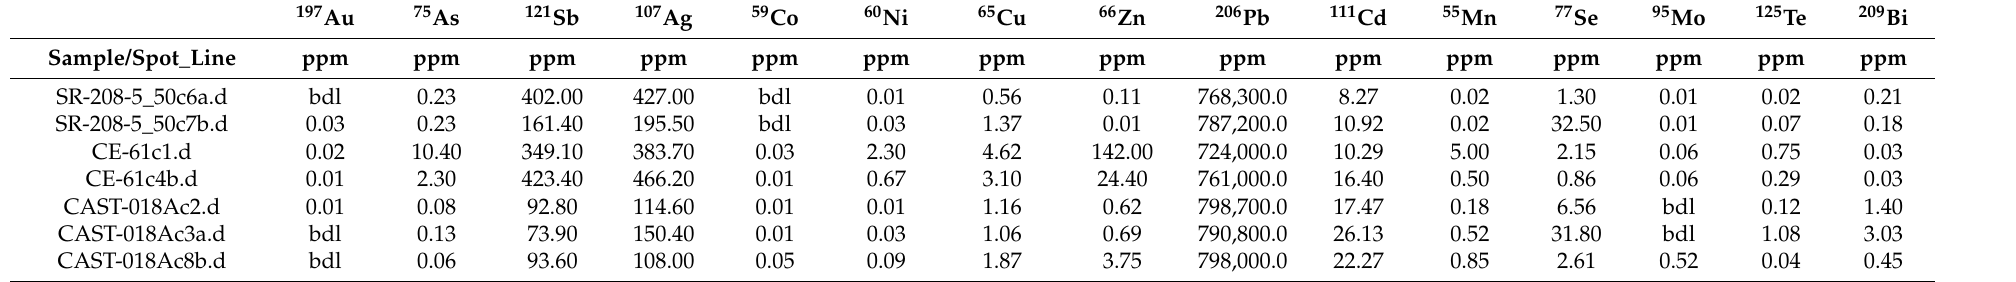
Table A4. Gold and other trace element contents in galena obtained by